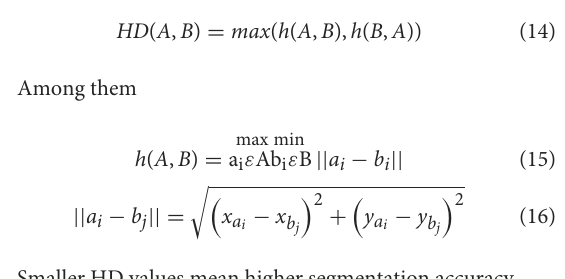
FIGURE9 Structure diagram of deconvolution